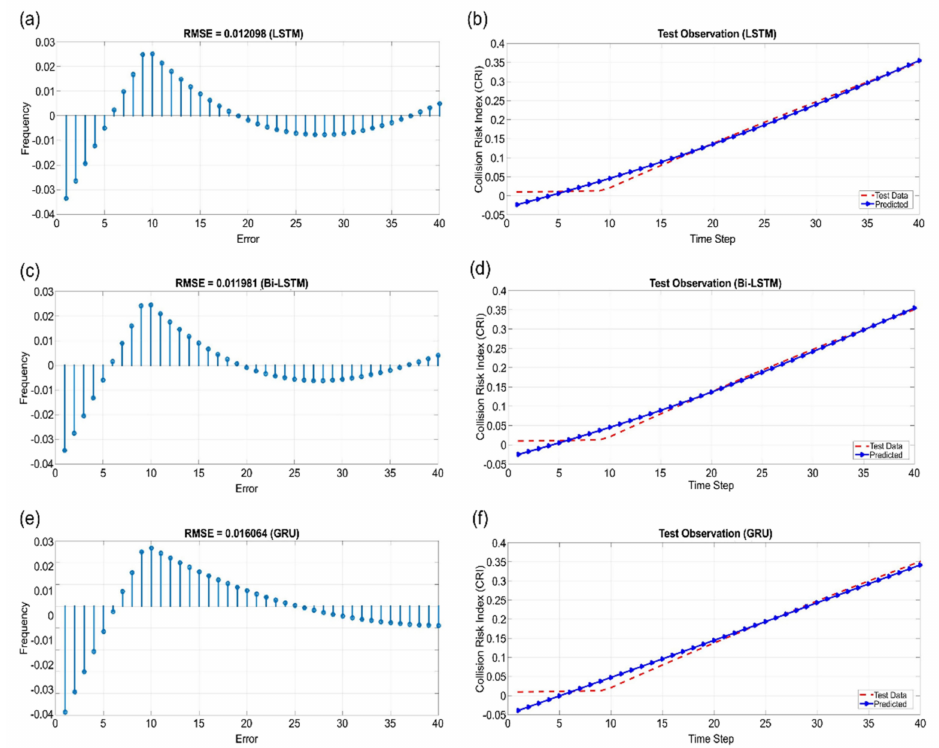
Figure 11. Sector I: ( a ) RMSE of LSTM, ( b ) test observation of LSTM, ( c ) RMSE of Bi-LSTM, ( d ) test observation of Bi-LSTM, ( e ) RMSE of GRU, and ( f ) test observation of GRU.